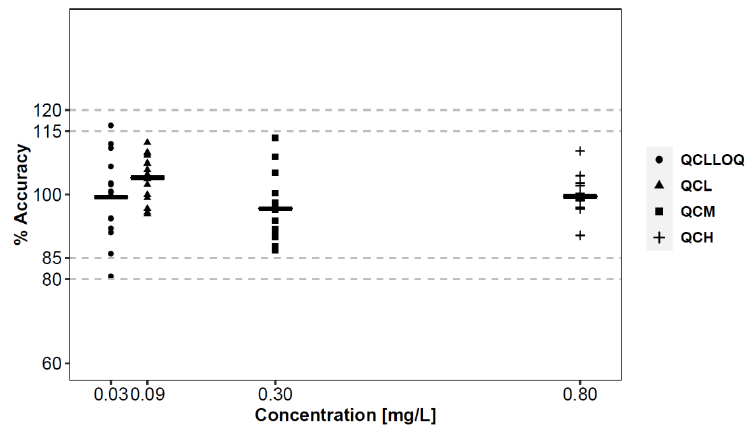
Figure 3. Inter-day and intra-day ( n = 15, 5 replicates per QC tier at each validation day) accuracy of the developed method in MHB bacterial growth medium determined from QC samples; QCLLOQ = QC tier LLOQ, QCL = QC tier at 3 × LLOQ, QCM = QC tier in the medium calibration range, QCH = QC tier higher at 80% of highest concentrator, crossbar = mean ( n = 15).